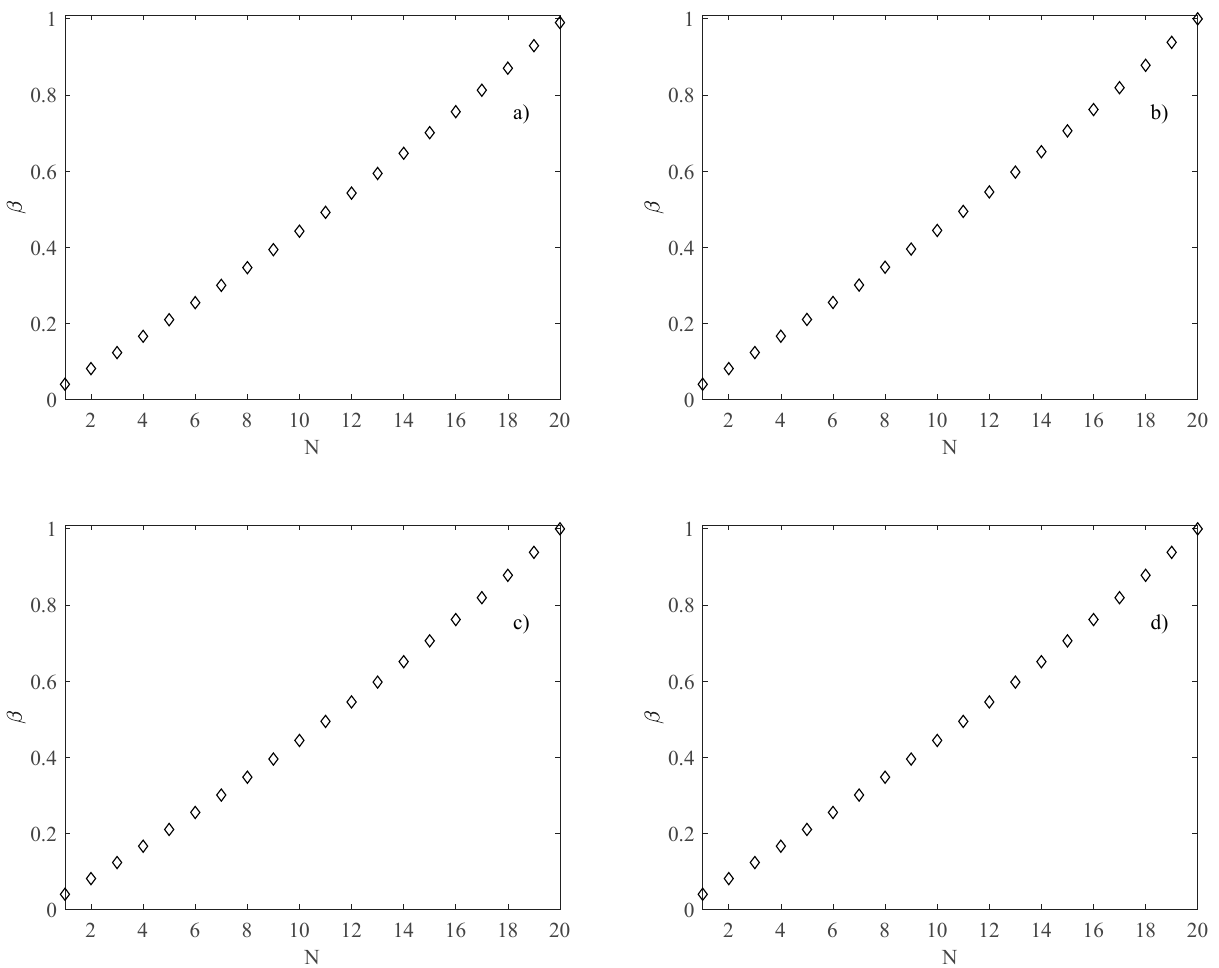
Figure 4. β as a function of the number of rectangular channels; ( a ) B = L = 2.5 mm; ( b ) B = L = 5 mm; ( c ) B = L = 10 mm; ( d ) B = L = 20 mm.